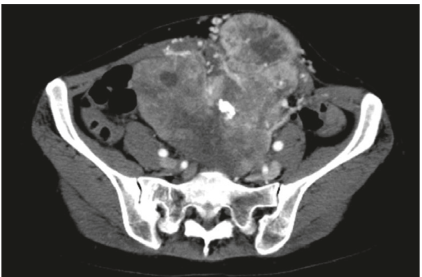
Figure 2: Enhanced computed tomography findings at the initial visit. CT revealed marked dot-like enhancement at the arterial phase, suggesting abundant vascular formation.